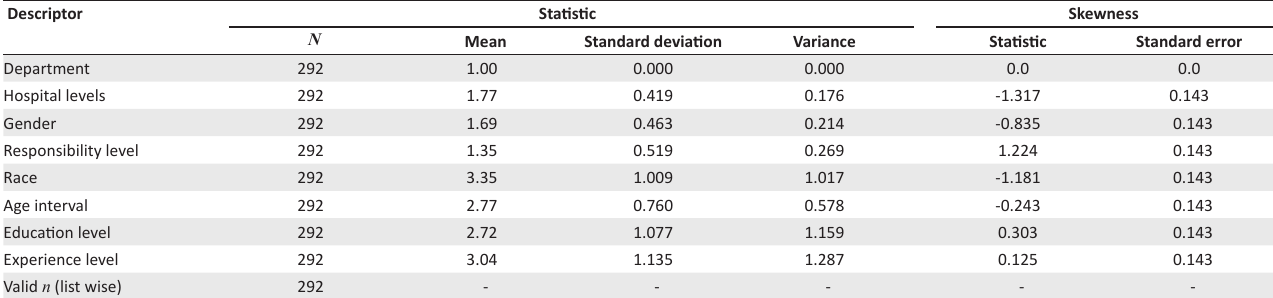
TABLE 4: Descriptive statistics of demographics of the EPMDS effectiveness